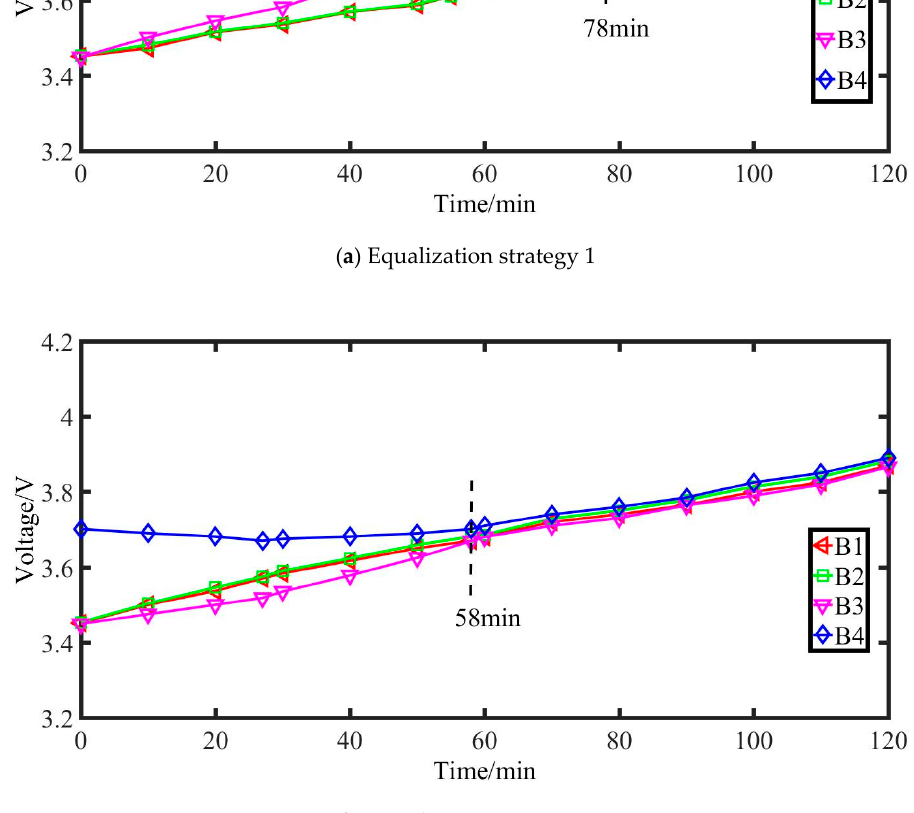
Figure 17. Experimental results of active equalization in charging state.